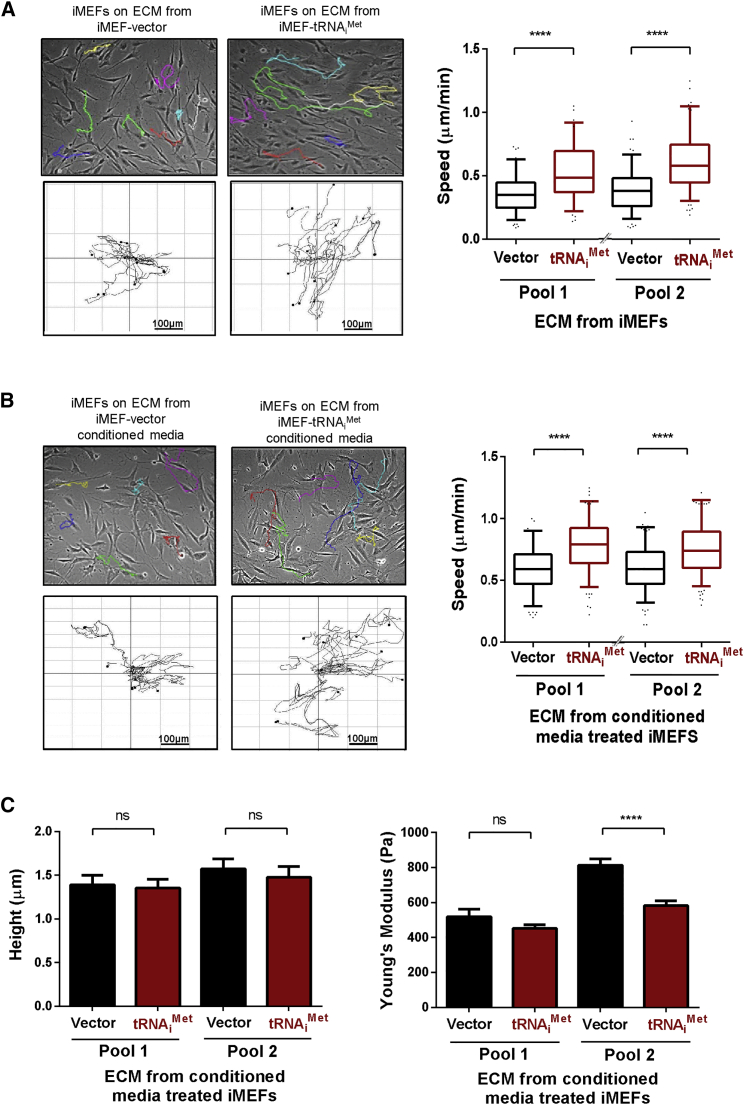
tRNAiMet Supports Deposition of Pro-migratory ECM via Release of Secreted Factors(A) Migration of iMEFs on ECM was recorded by time-lapse microscopy over a 17-hr period and analyzed using ImageJ. ECM was generated using immortalized fibroblasts (iMEFs) stably overexpressing either empty vector (iMEF-vector) or tRNAiMet (iMEF-tRNAiMet). See Figure S3 for characterization of these cells.(B) ECM was generated by iMEFs in the presence of conditioned media from iMEF-vector or iMEF-tRNAiMet cells. All data represent ECM generated from at least three independent ECM isolations, tracking the migration of at least 40 iMEFs in each replicate. Box and whisker plot represents 5–95 percentile; Mann-Whitney test; ∗∗∗∗p < 0.0001.(C) Atomic force microscopy and contact imaging were performed using a JPK NanoWizard II Bio AFM in combination with a Bruker MLCT cantilever and to measure the thickness of ECM following wound scratch or a Nanoworld Arrow TL-1 cantilever with bead attached for force spectroscopy; n = 3 independent ECM generations; ±SEM; ∗∗∗∗p < 0.0001; ns, no significant difference; Kruskal-Wallis test.